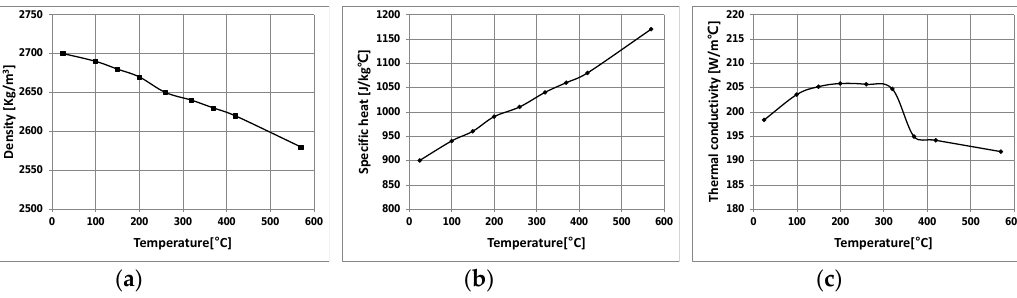
Figure 9. Finite element (FE) model for heat transfer analysis: ( a ) top view; ( b ) isotropic view.